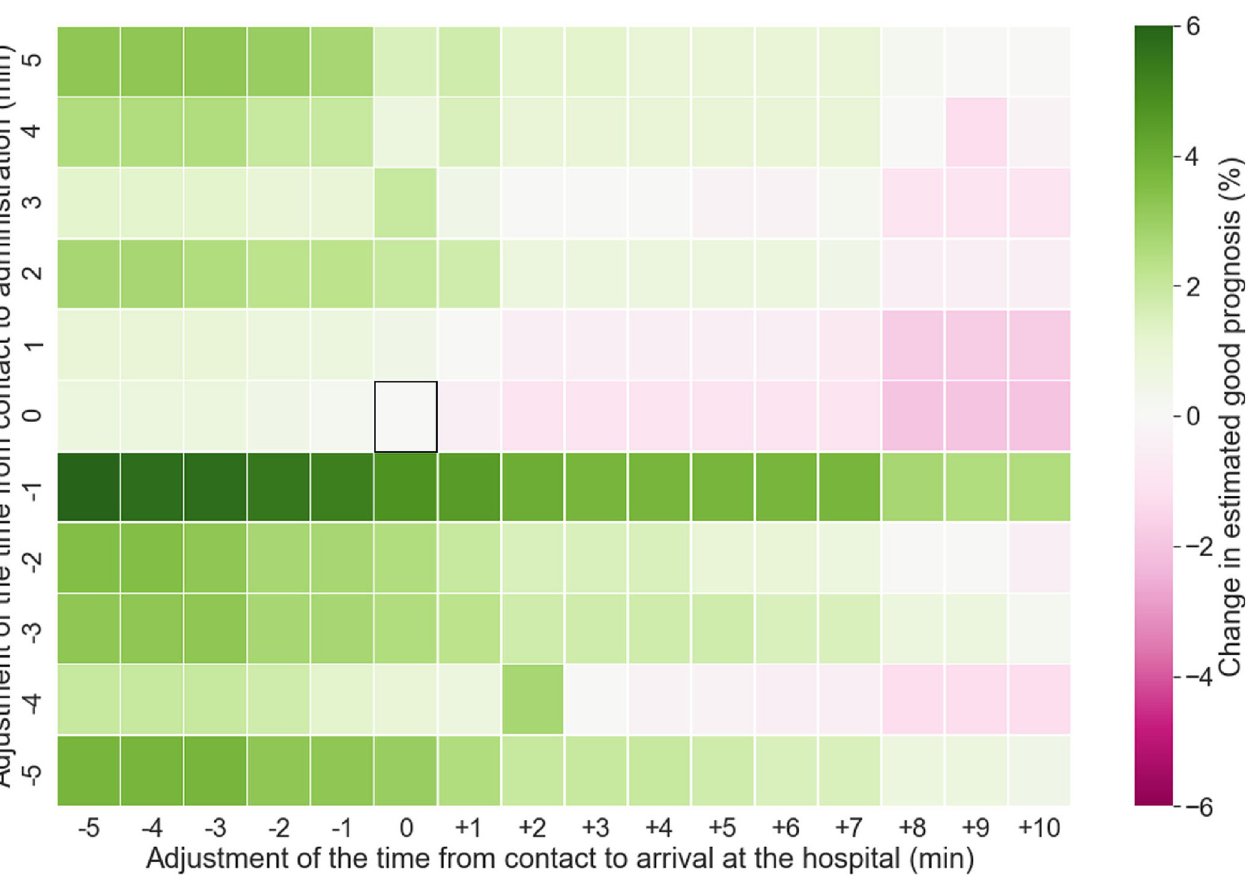
Fig 5. Modification of times from ambulance contact to hospital arrival and first-drug administration. The square box indicates no adjustments. The two ends of the color spectrum show a 6% increase and decrease in predicted CPC1/2, respectively. Overall, reducing the time for hospital arrival improved outcomes, whereas delays worsened them. Reducing the time to drug administration strengthened the effect of reducing the transport time, but reducing the transport time improved the prognosis even with delayed drug administration. CPC, cerebral performance category.